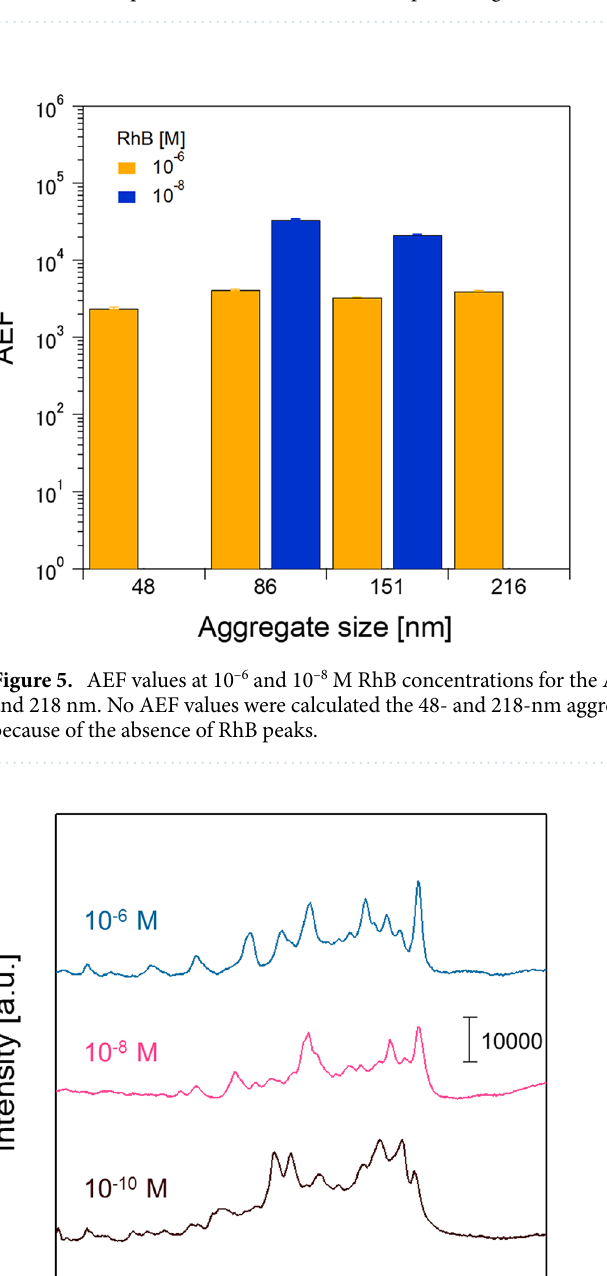
Table 1. Main peaks of Rhodamine B and the peak assignments.